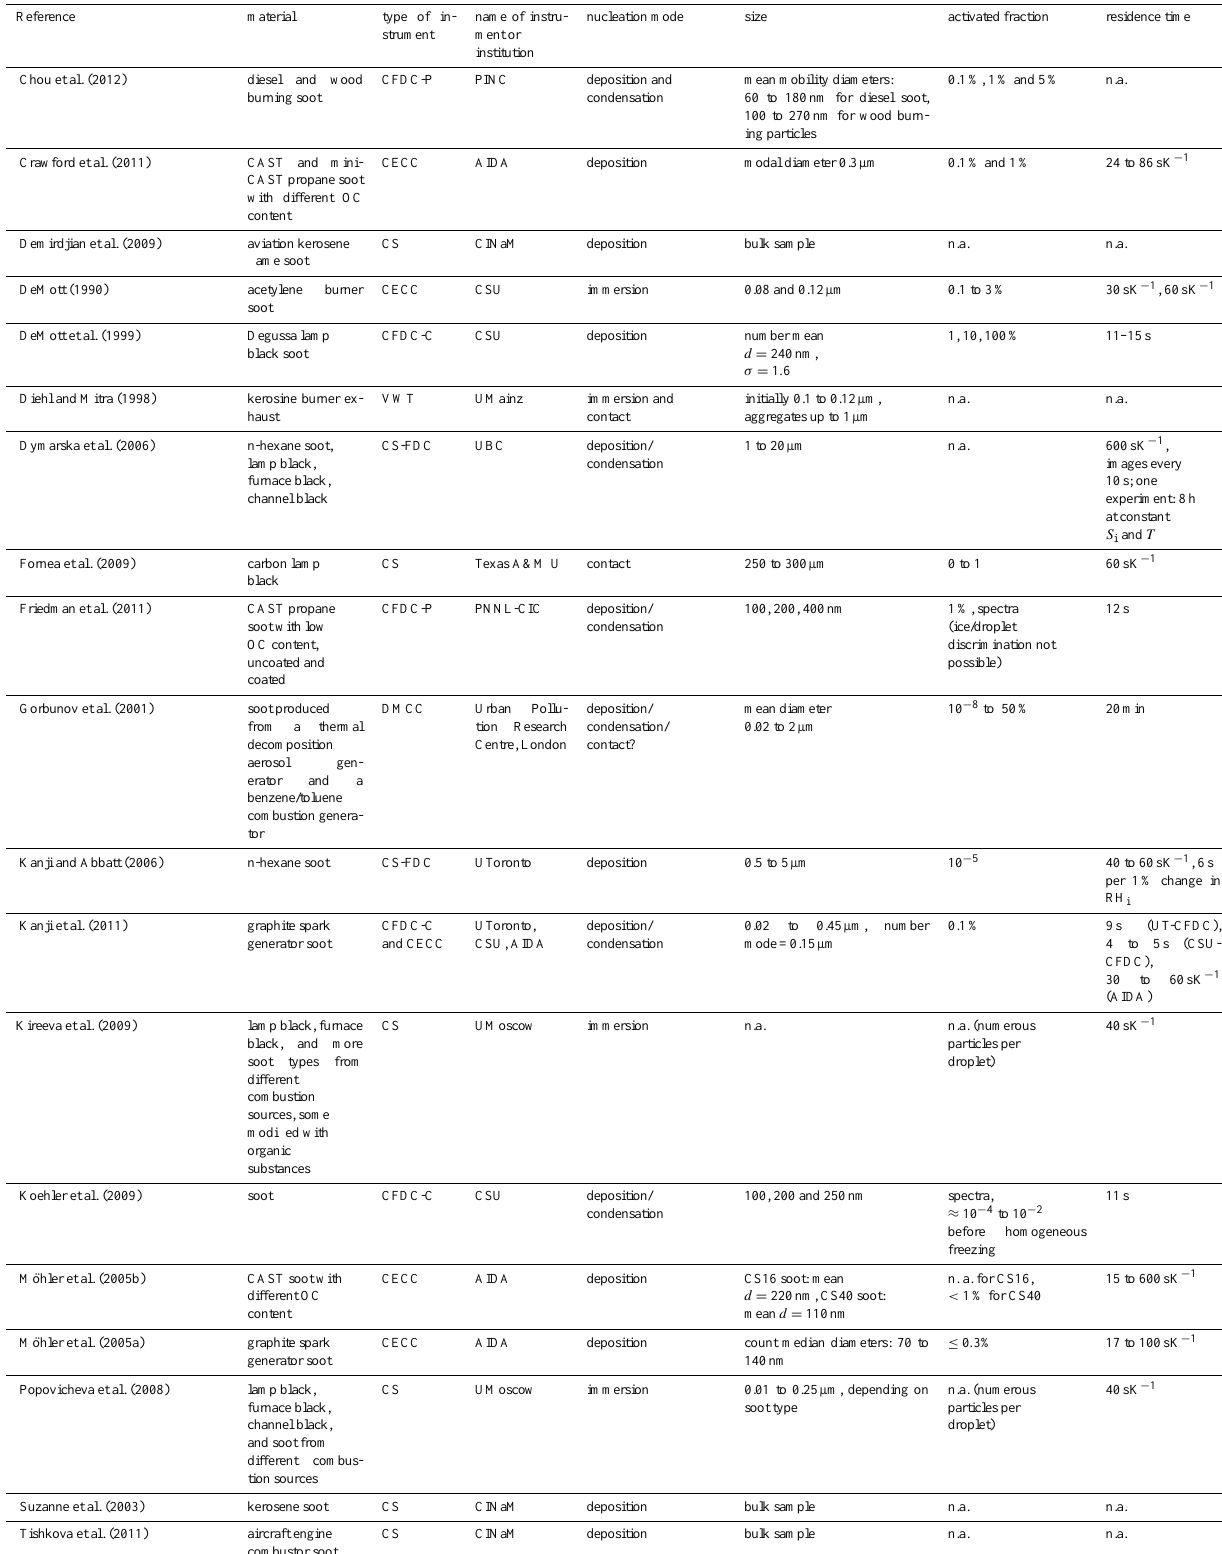
Table 2. Laboratory experiments with soot